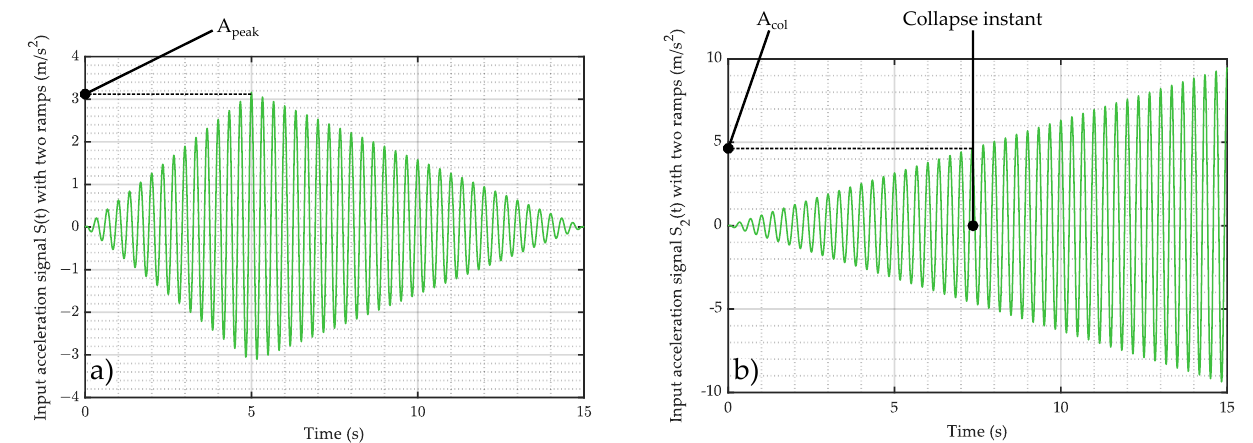
Figure 12. Example of the harmonic input signals S ( t ) used in the numerical simulation of full-scale DSRWs with a frequency of f = 3Hz. ( a ) S 1 ( t ): signal with two ramps, idealising a seismic signal and ( b ) S 2 ( t ): signal with an infinitely increasing ramp. Note that the increasing ramps of both signals have the same slope.